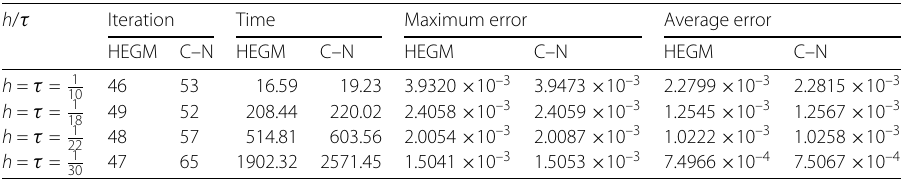
Table 1 Comparison between Crank–Nicolson (C–N) high-order finite difference method and HEGM for Example 1 when γ = 0.75